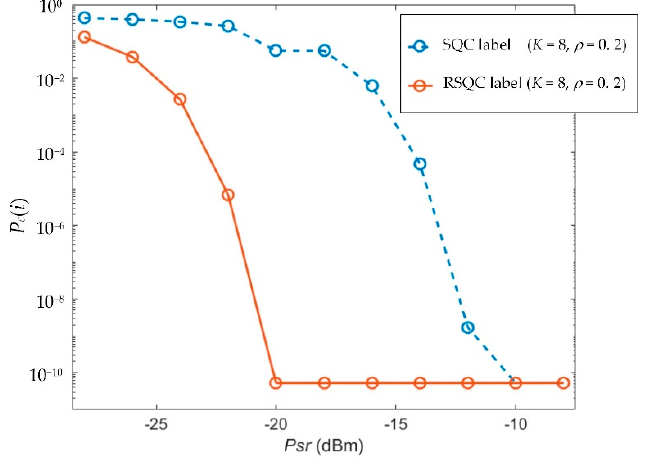
Figure 6. The functions from traffic intensity to code-error rate.